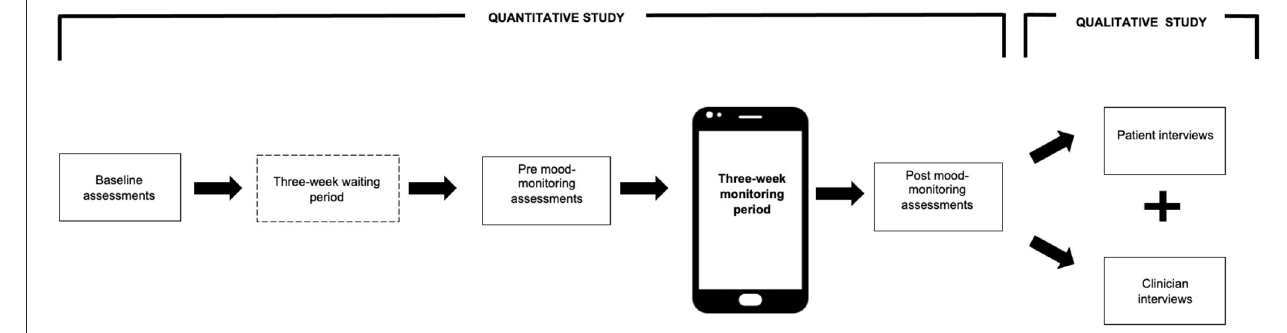
FIGURE 1 | Overview of study design.